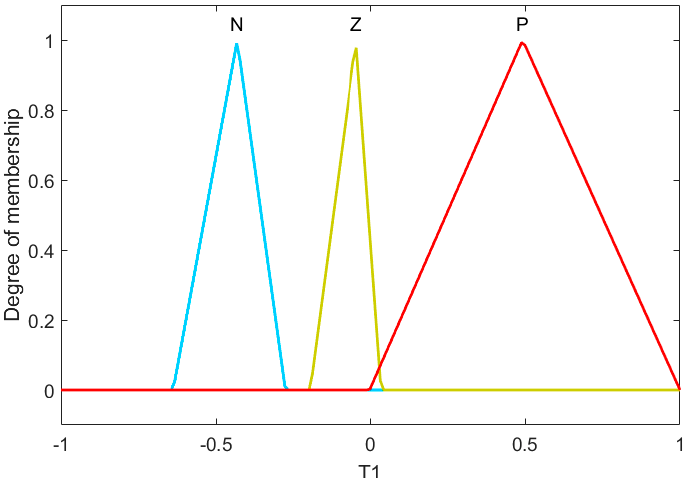
Algorithms 2019 , 12 FOR PEER REVIEW 19 Figure 19. Output 1 optimized by DSO. Figure 19. Output 1 optimized by DSO.